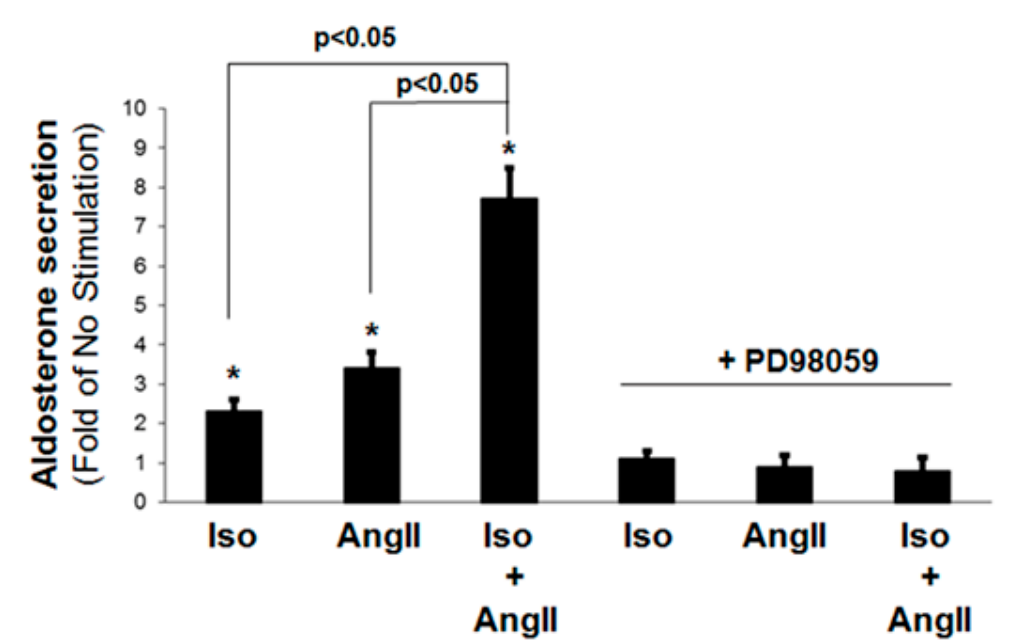
Figure 1. Synergistic effect of catecholamines and AngII on stimulation of aldosterone secretion from H295R cells. Aldosterone secretion in vitro by H295R cells stimulated for 6 h with 10 µM isoproterenol alone (Iso), 100 nM AngII alone (AngII), or both (applied simultaneously) (Iso + AngII). The results of each of these treatments in the presence of 50 µM PD98059 are also shown. The data are expressed as fold of the response to vehicle (No Stimulation). *, p < 0.05, vs. no stimulation (vehicle); n = 5 independent experiments/treatment.